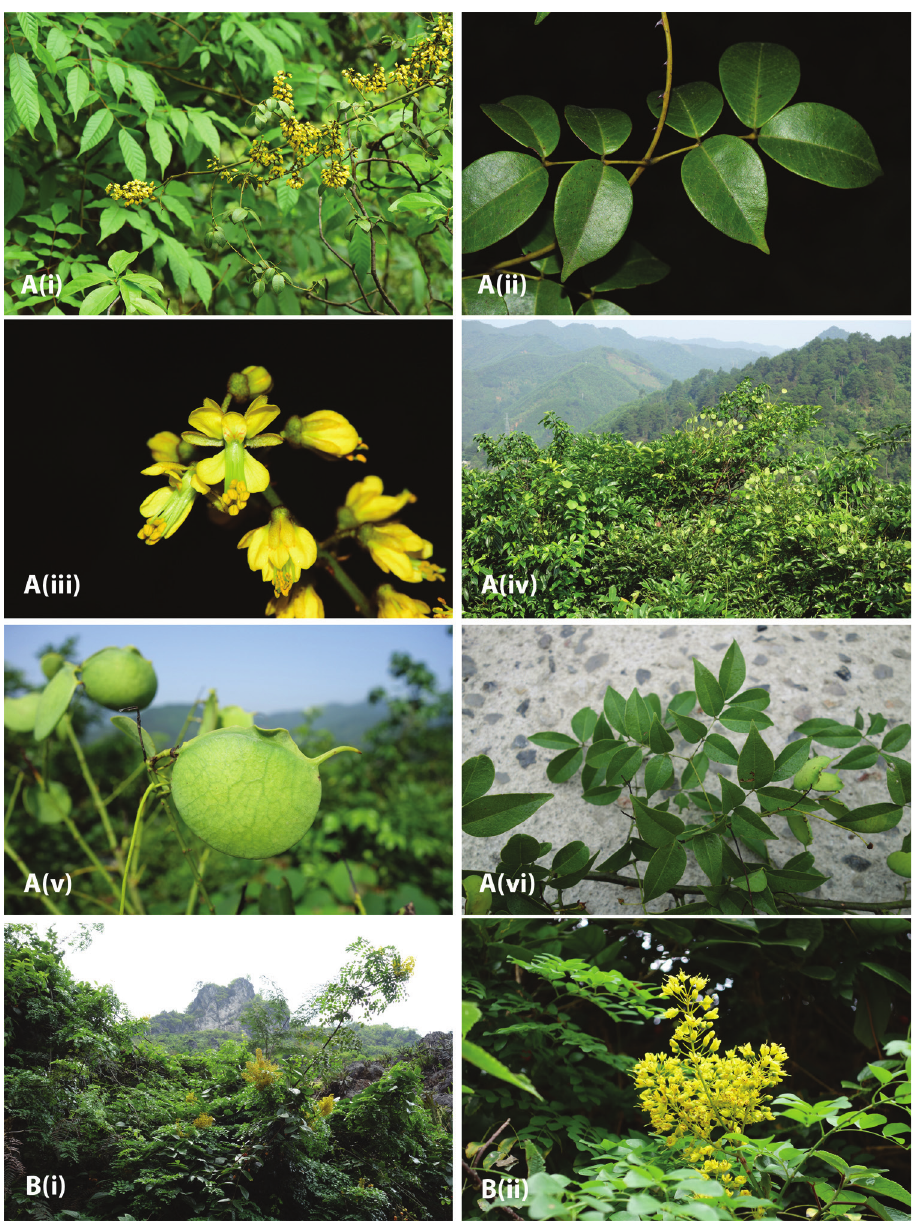
Figure 3. A T. sinensis (i) habit (ii) leaves (iii) flowers (photos by Xin-Xin Zhu, Guizhou, China, unvouchered ) (iv) habit (v) fruit ( R.P. Clark 429 , Guangxi, China, (IBK, K)) (vi) leaves ( R.P. Clark 415 , Guangxi, China (IBK, K) B T. aff. szechuenensis (i) habit (ii) inflorescence and leaves ( R.P. Clark 422 , Guangxi, China (IBK,